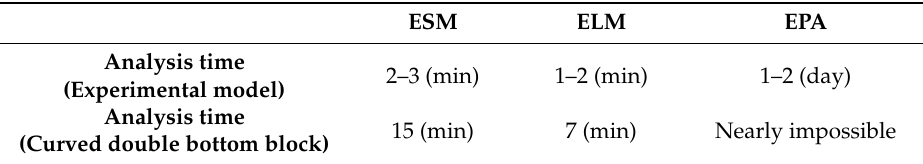
Table 3. Comparison of analysis